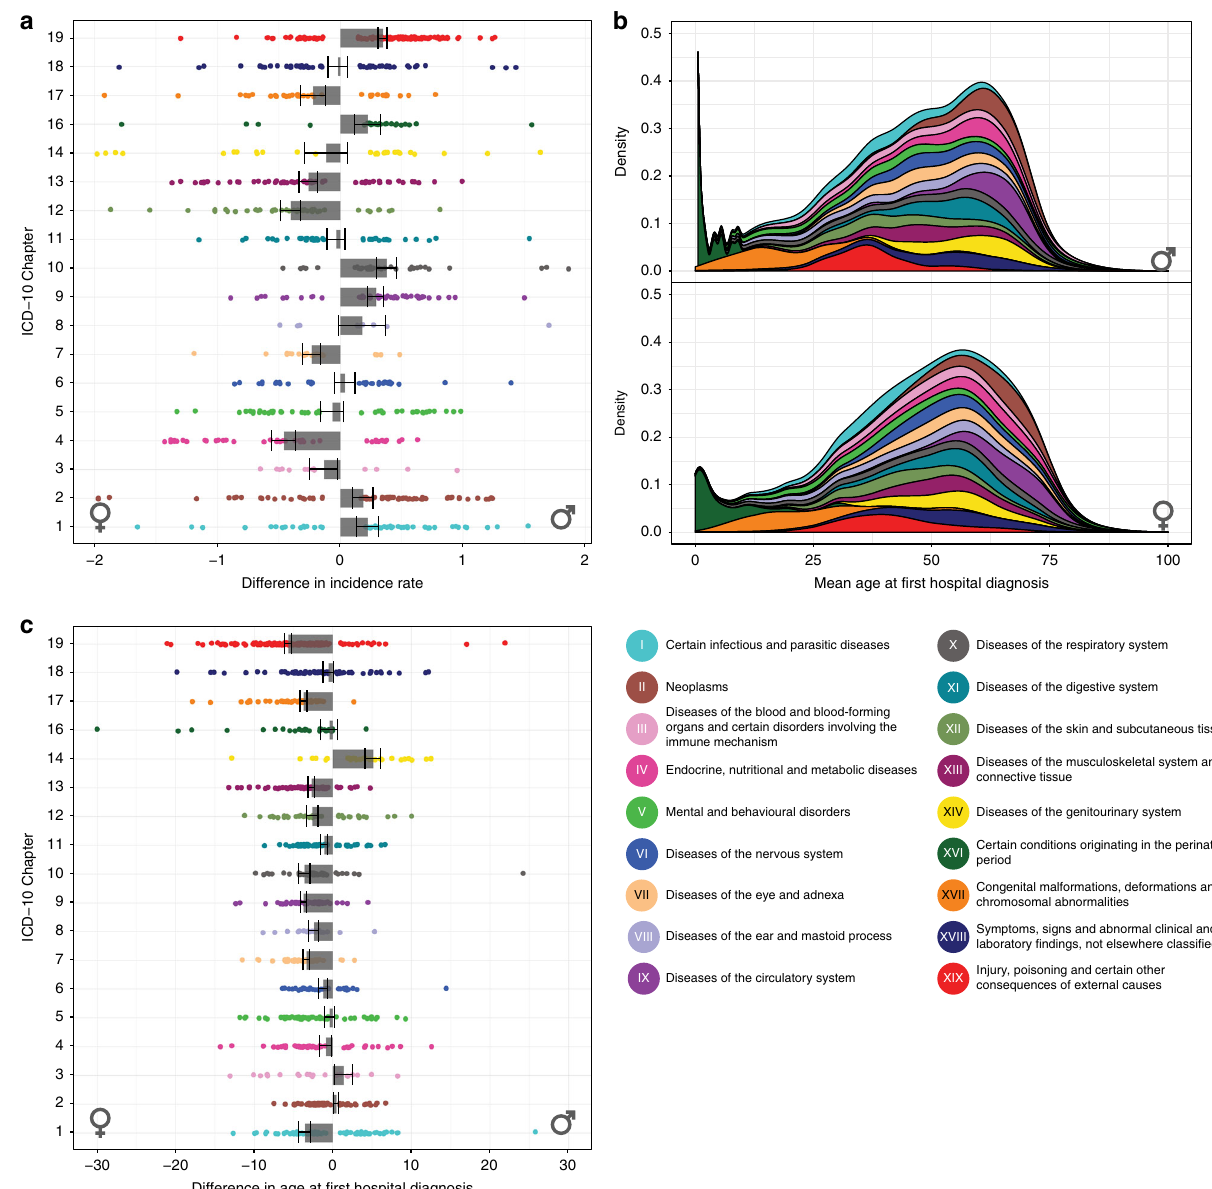
Fig. 1 Incidence and age at fi rst hospital diagnosis of 1369 diagnoses. a 344 and 437 diagnoses were found to have a higher age-adjusted incidence rate in men and women, respectively. b Mean age at fi rst diagnosis for each of the 1369 diagnoses studied. c Mean of the difference in age at fi rst diagnosis. We found 963 diagnoses in which the age at fi rst diagnosis was statistically signi fi cant when comparing men and women (Welch ’ s t test, FDR < 0.05). Errors bars are the standard error of the mean per ICD-10